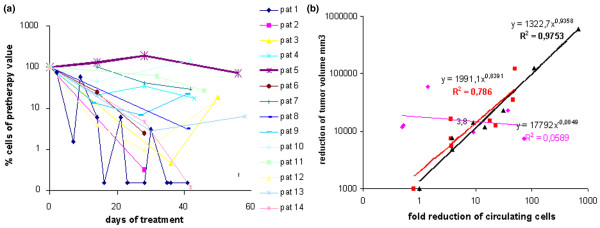
Changes in circulating tumour cell numbers. (a) Fourteen typical courses of changes in cell numbers in breast cancer patients monitored during neoadjuvant (primary) therapy. (b) Comparison of the response of circulating tumour cells during the first three (or four) therapy cycles versus tumour reduction in the therapy regimen without herceptin (thick lines) and the regimen including herceptin (thin line).